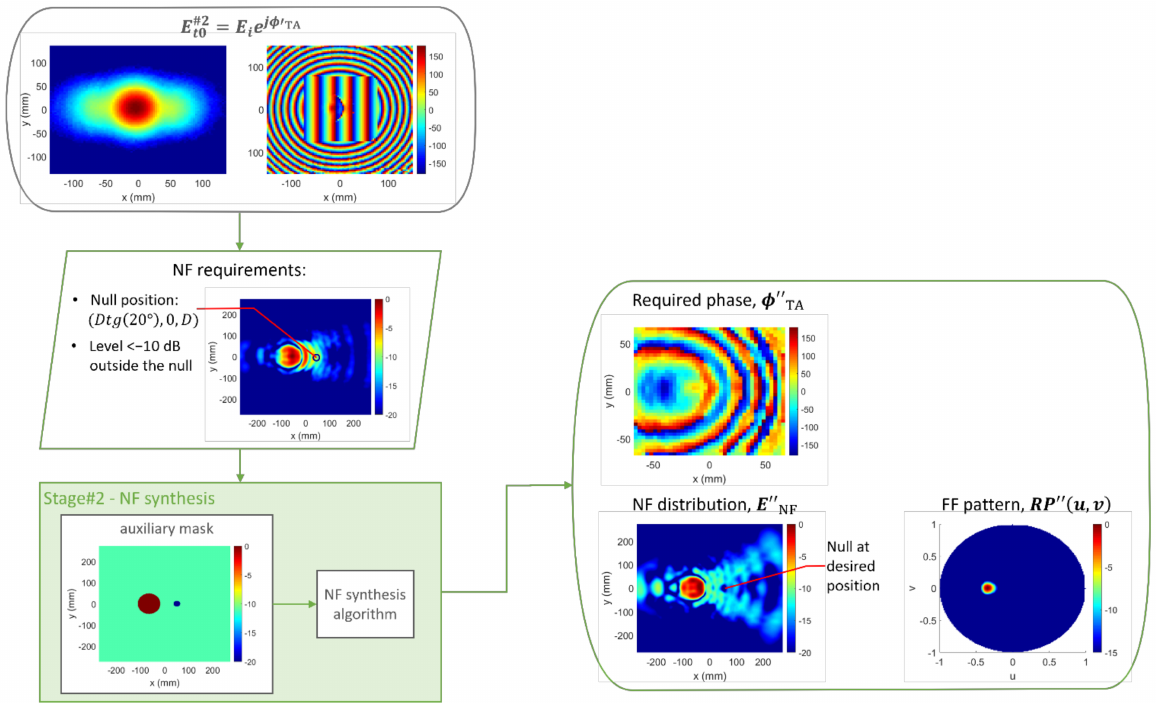
Figure 7. Case 1, Stage#2: inputs and outputs. Field magnitudes are presented normalized in dB, and the phases are presented in degrees.